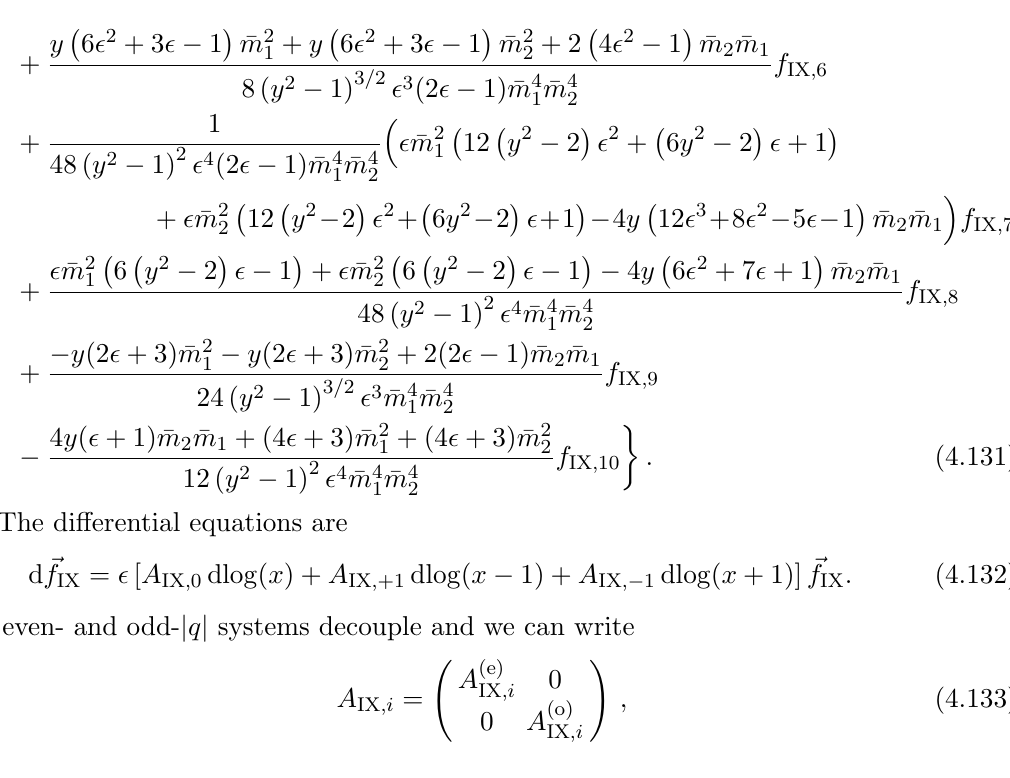
q master integrals relevant for the non-planar double-box j j